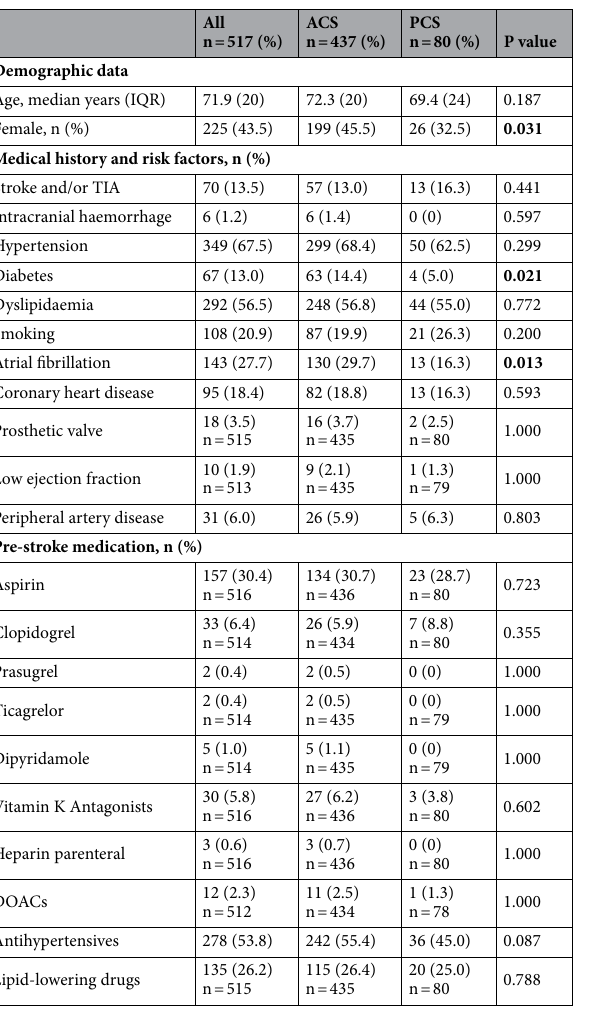
Table 1. Patient clinical characteristics. Clinical characteristics of all 517 patients and patient groups according to stroke territory, anterior circulation stroke (ACS) and posterior circulation stroke (PCS). Data are expressed as number of patients (n) and percentages or median and interquartile range (IQR). TIA indicates transient ischaemic attack; DOACs, direct oral anticoagulants (i.e. Rivaroxaban, Dabigatran, Apixaban). P values were obtained according to Mann–Whitney U test, Pearson’s Chi-squared test and Fisher’s Exact test, where appropriate. P values < 0.05 are shown in